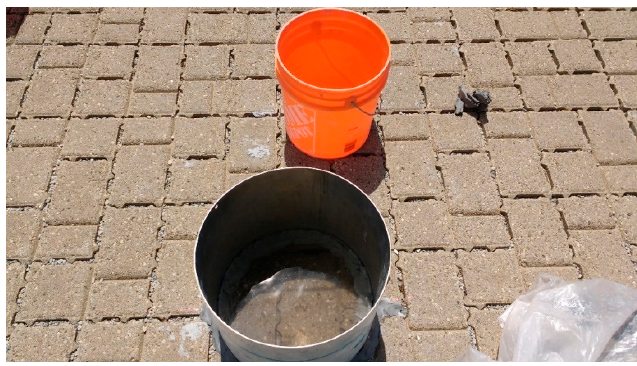
Figure 6. Standing water during a failed Infiltration test at CVC, Mississauga, Canada.